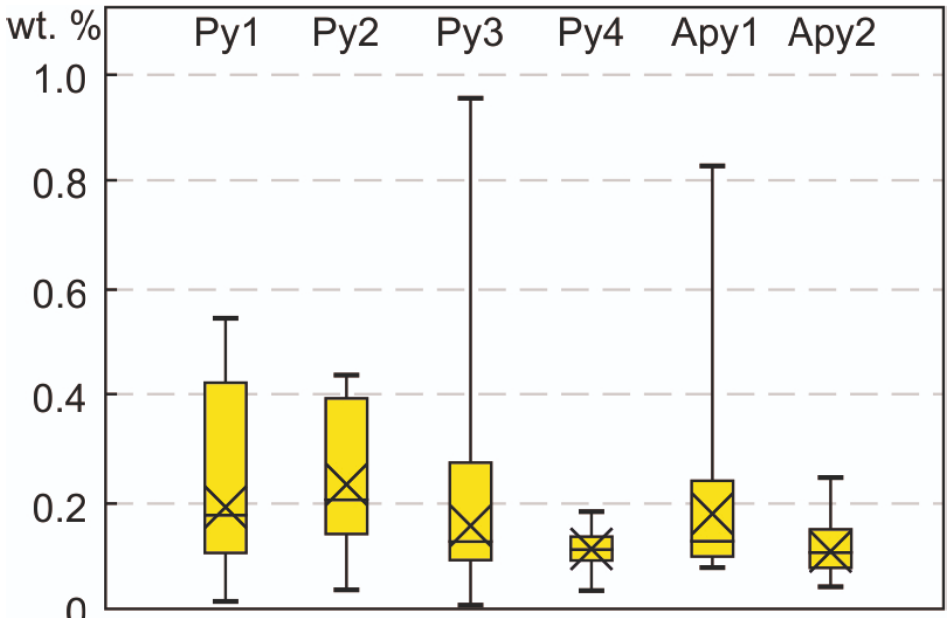
Figure 11. Variations in total content of Co, Ni, Sb, Cu, and Pb (wt.%) in sulfides of different generations, Khangalas deposit. Box boundaries are first and third quartiles, and line in middle of box is median. Lower border of line shows minimum value, upper shows maximum value, cross shows average